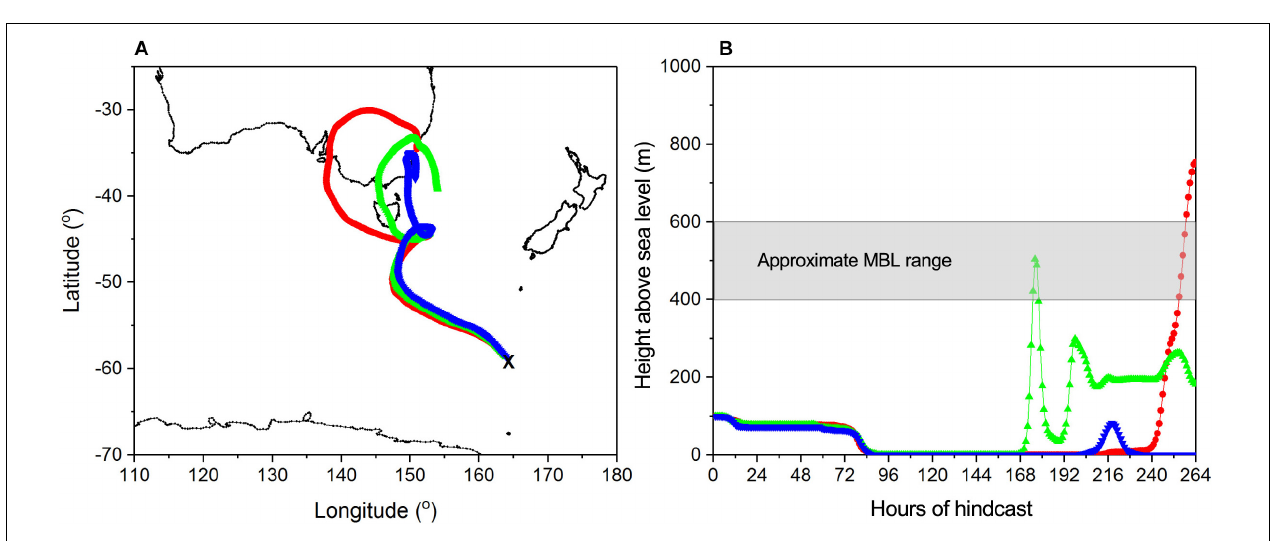
FIGURE 3 | Back trajectories, (A) x-y and (B) x-z projections, associated with a mid-Southern Ocean radon enhancement event originating from south eastern Australia observed by the RV Investigator . Typical height range of the mid-Southern Ocean marine boundary layer inversion indicated.